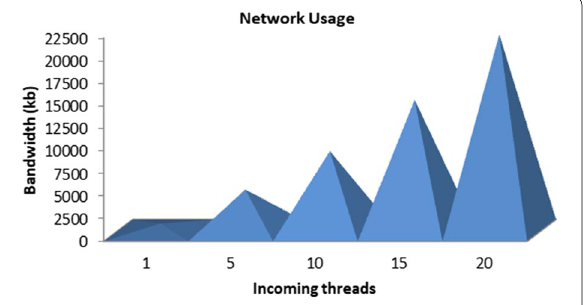
Fig. 7 Network usage for various configurations